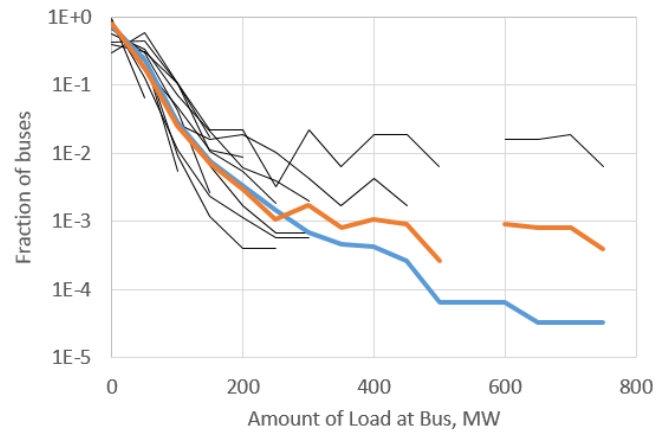
Figure 2. Probability mass function of the amount of load at load buses, for EI (blue), WECC (orange), and 12 subset cases (black).